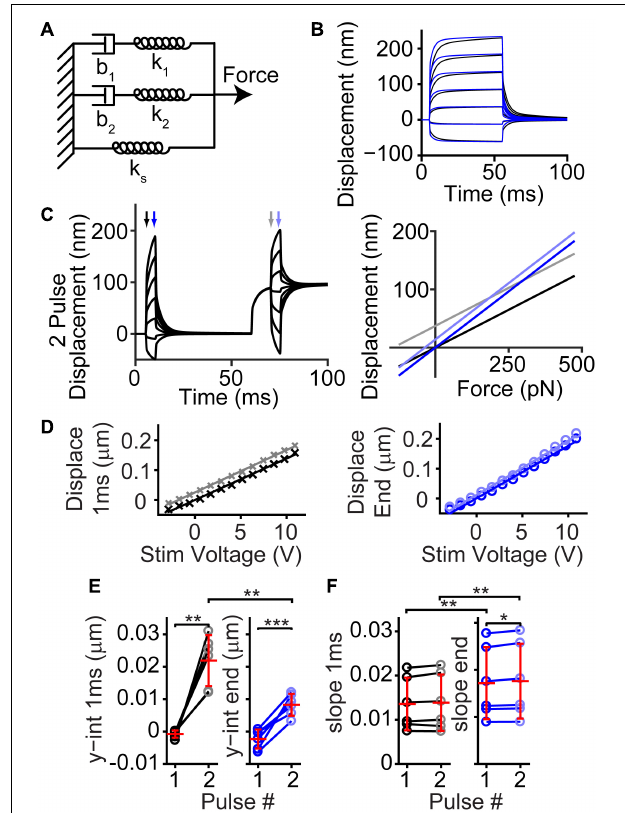
FIGURE 7 | Simple passive linear mechanical model explained the general shape of the complex hair bundle motion. (A) Passive mechanical model with a combination of springs (k) and dashpots (b) mimicking the classic model of motor adaptation with a second spring-dashpot combination to add the second creep time constant observed in hair bundle motion is shown. (B) Black lines are the resulting motion based on the model in panel (A) using 100 pN step sizes starting at –125 pN, blue lines indicate the resultant motion when k s and force applied is increased 2-fold, resulting in a similar effect as seen with fixed tissue (Caprara et al., 2020). (C) Using the same linear model, a 2-pulse experiment resulted in similar bundle motions (left) and changes in slope and intercept as observed in panel (D) . Displacement vs. force lines were taken at timepoints indicated by arrows in the displacement graph. (D) Plots of the bundle displacement at 1 ms and 3.9 ms (near the end of the stimulus) after stimulus onset for –84 mV data (analyzed from Caprara et al. (2019) Figure 3A) show a roughly linear relationship with fluid-jet stimulus voltage. Linear fits of the data indicate the slope (indicator for the effective stiffness of the hair bundle) and y-intercept (indicator of the offset of the hair bundle). (E) Summary of the y-intercepts indicated a positive shift in the hair bundle displacement with stimulation size between the first and second activation curves supporting the presence of a mechanical dashpot ( n = 6, y-int 1 ms, p = 0.0015; y-int end, p = 0.00094). (F) Changes in the slopes of the fit indicated little change between pulses at the same time point, but a clear difference between the beginning and end of the short activation curve pulse indicating a change in effective stiffness ( n = 6, Pulse 1, p = 0.0040, Cohen’s d = 0.53; Pulse 2, p = 0.0036, Cohen’s d = 0.52). * p < 0.05, ** p < 0.01, and *** p <